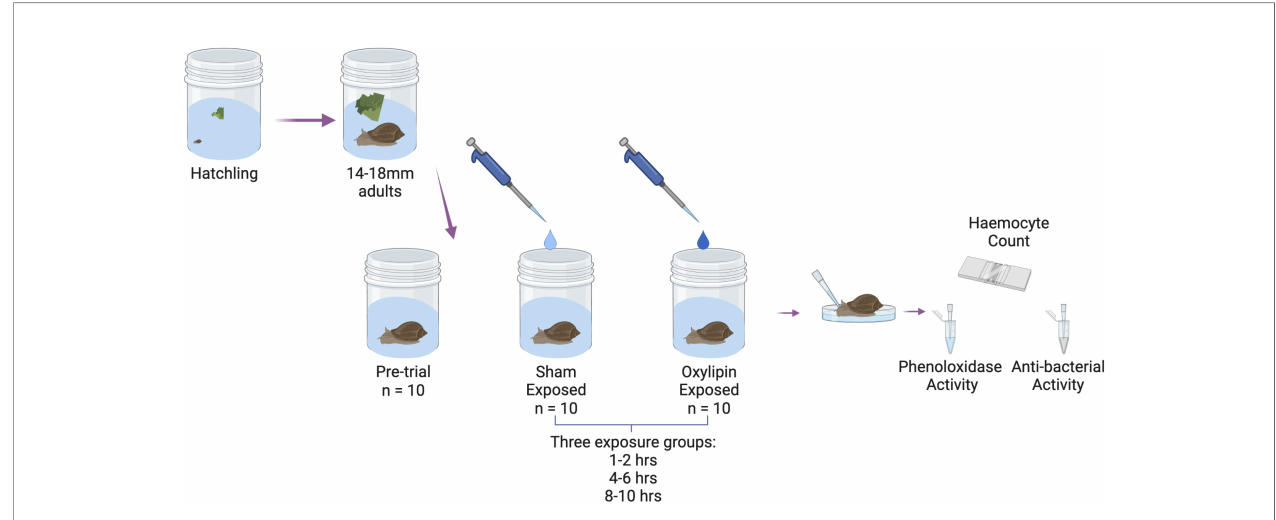
FIGURE 1 | Schematic of experimental design of experiment 4 - testing the role of oxylipin signaling molecules in DDP. Created with